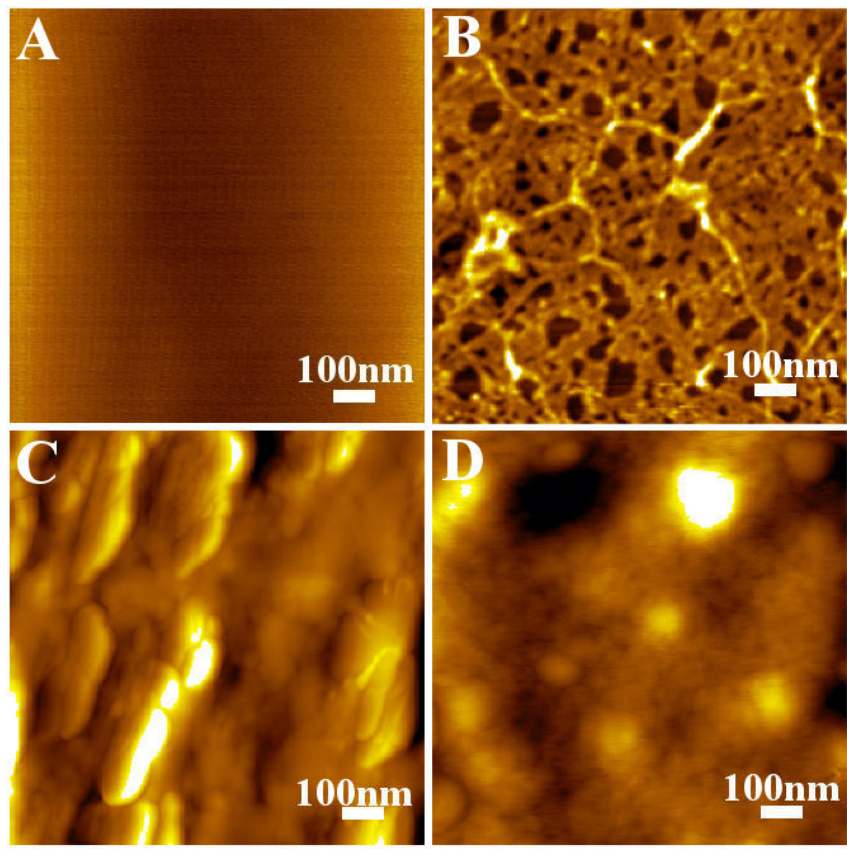
Figure 3. MAC Mode AFM topographical images in air of: (A) clean HOPG electrode; (B) thin film dsDNA-biosensor surface, prepared onto HOPG by 3 min free adsorption from 60 µ g/mL dsDNA in pH 4.5 0.1 M acetate buffer; (C) thick film dsDNA-biosensor, prepared onto HOPG by evaporation of 3 consecutive drops each containing 5 µ L of 50 µ g/mL dsDNA in pH 4.5 0.1 M acetate buffer; (D) thick film dsDNA-biosensor, prepared onto HOPG by evaporation from 37.5 mg/mL dsDNA in pH 4.5 0.1 M acetate buffer. [From Ref [17] with